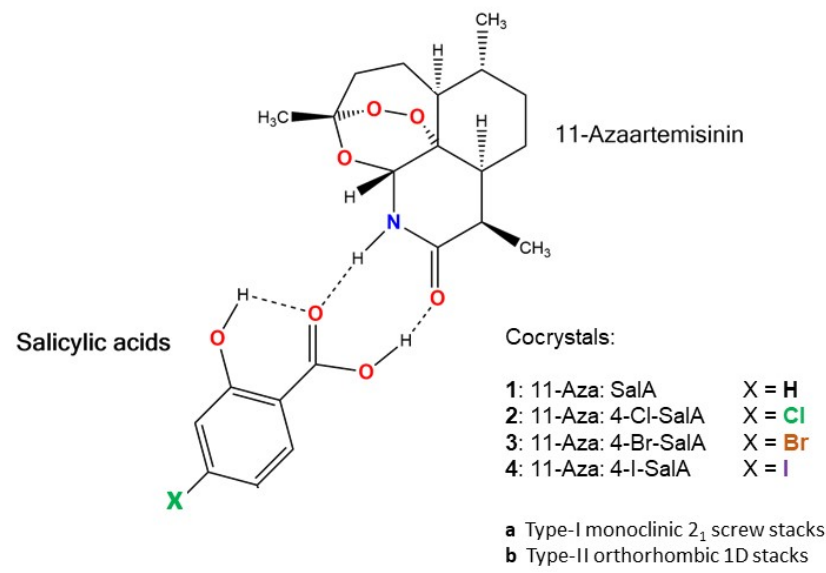
Figure 1. Molecular pairs of the 1:1 cocrystal phases of 11-azaartemisinin (11-Aza) and 4-X-salicylic acids (SalA-4-X), showing association through a lactam:acid heterosynthon.